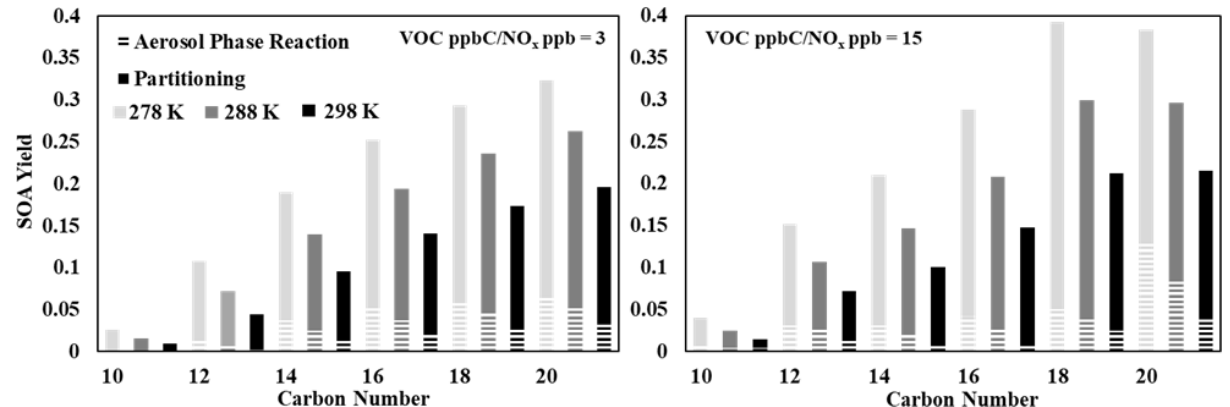
Figure 7. Simulated SOA yields, separated by OM P and OM AR , for a series of linear alkanes at three different temperatures and two different